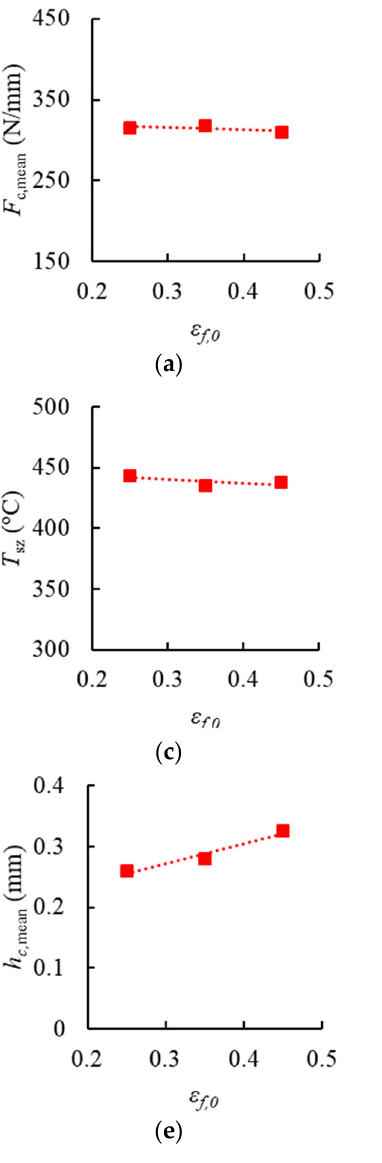
Figure 18. Effects of ε f,0 on ( a , b ) cutting forces, ( c , d ) cutting temperature and ( e , f ) chip morphology. Cutting conditions: V c = 7.5 m/min and f = 0.2 mm.